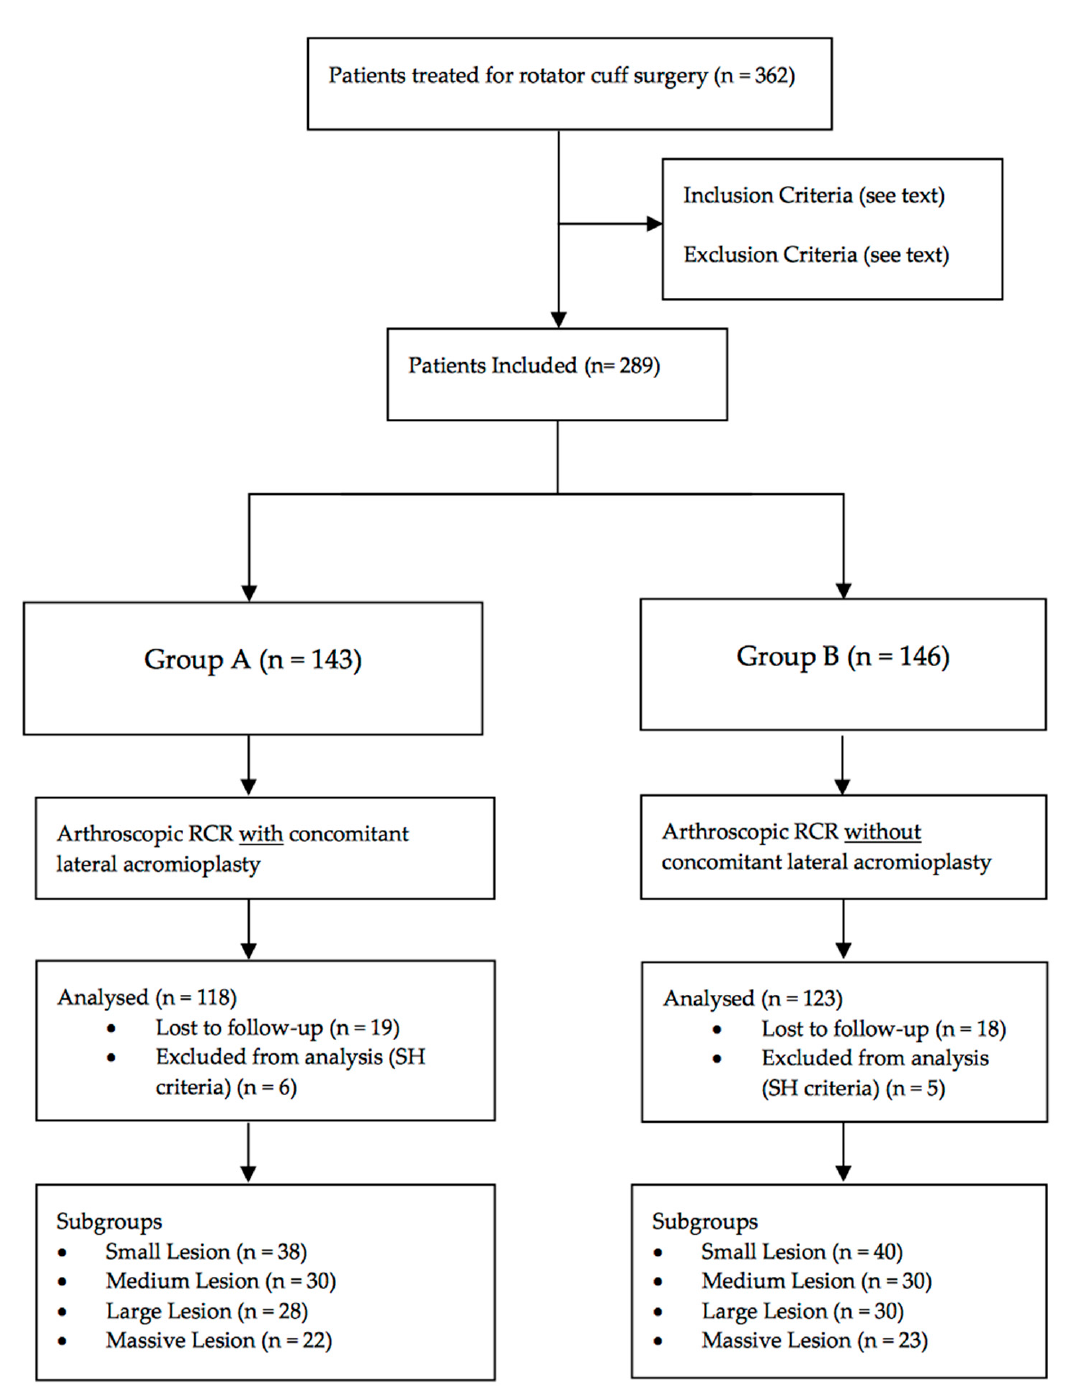
Figure 2. Flow Diagram of the current study.